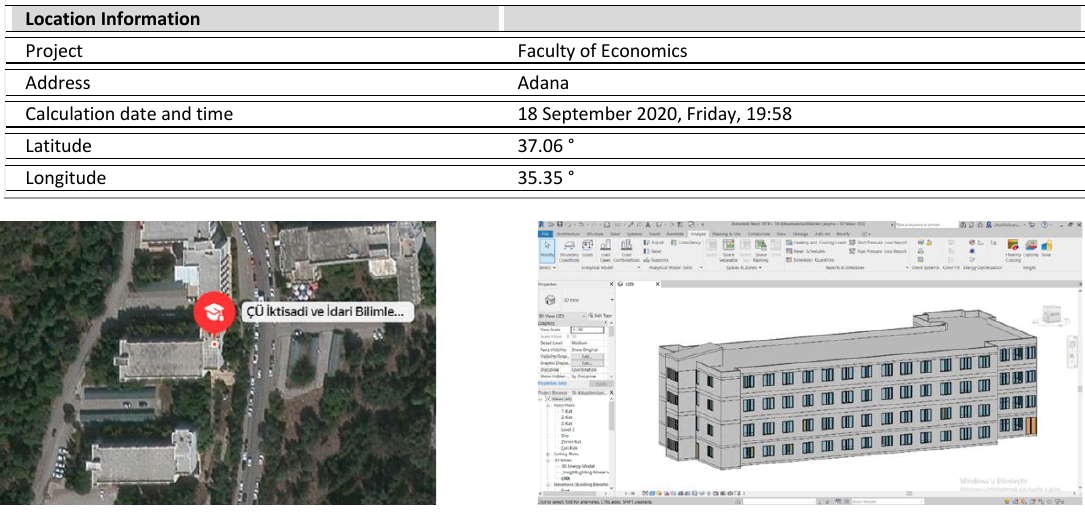
Figure 7 Map view of the Block A building of the Figure 8 The Revit model of the current situation of the